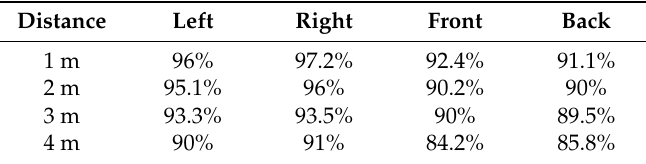
Table 3. Success rate of finding the direction according to the distance.